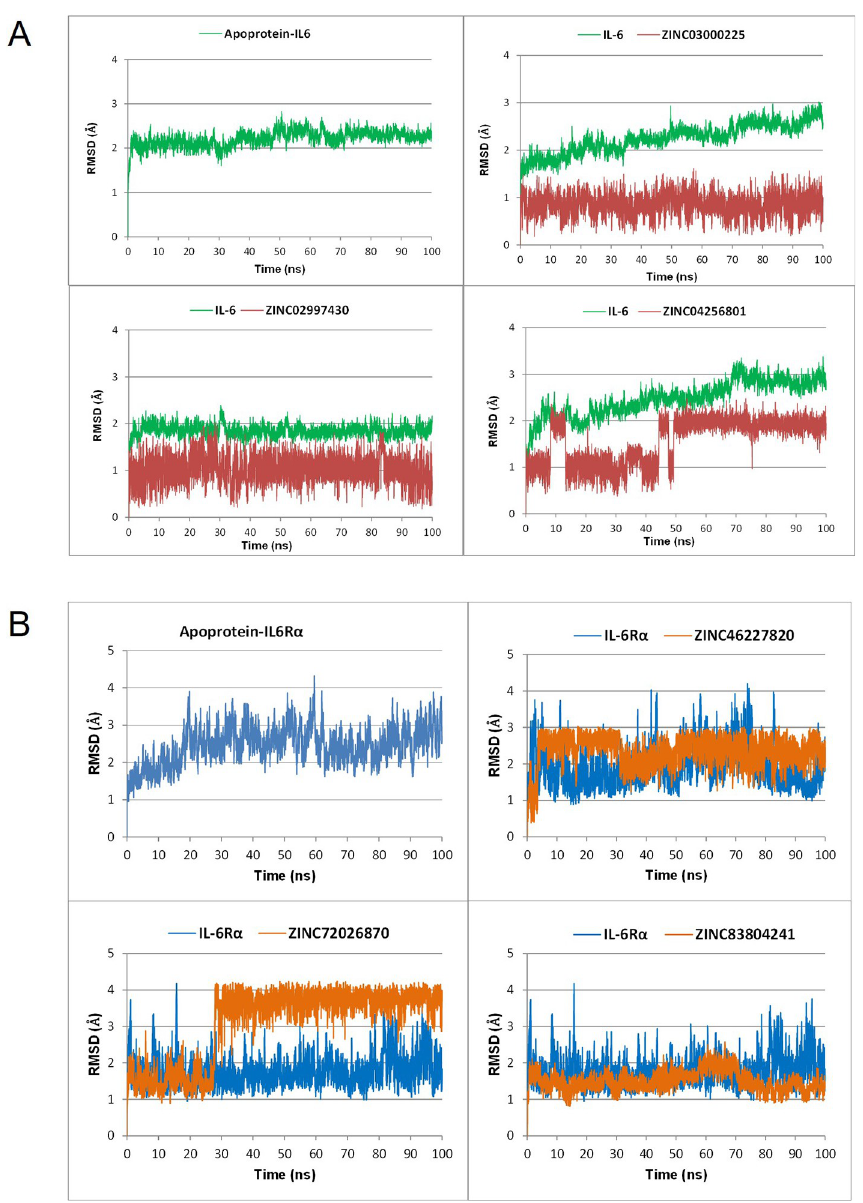
Fig 4. Carbon backbone RMSD profiles of the IL-6 (A) and IL-6R α (B) in apoprotein form and in complexes with 6 top ligands.